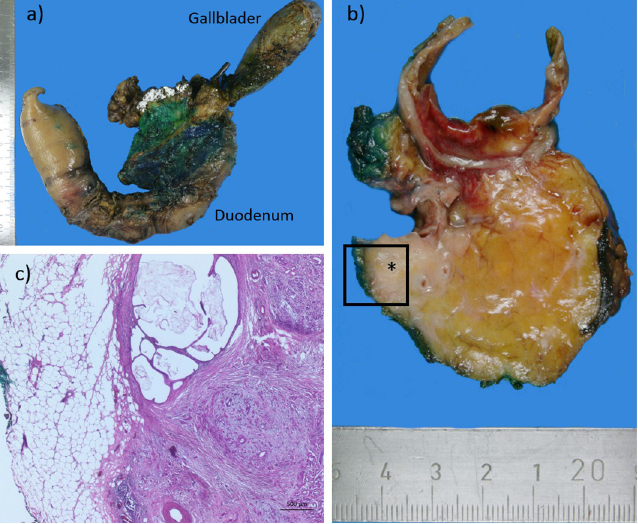
Fig 2. A pancreaticoduodenectomy specimen that was inked and assessed using the axial slicing technique. a) Color-marked Whipple resection (from dorsal); blue: retropancreatic area; green: vascular groove; white: pancreatic section margin. b) Cross-section of Whipple resectate with color-marked resection margins with the asterisk marking the pancreatic carcinoma in macroscopic section preparation. c) histological section preparation, distance to resection margin 0.2 cm (R0 wide, CRM